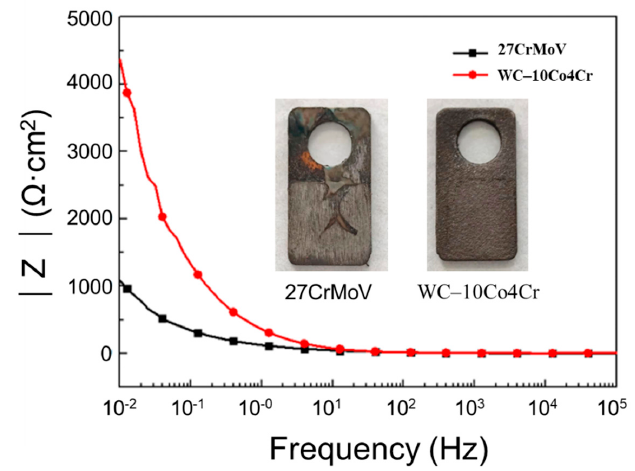
Figure 6. Bode diagram of EIS of 27CrMoV and WC–10Co4Cr coatings measured in saturated saline solution. The inset images show the macroscopic morphology of the sample after the corrosion test. The erosion behavior of the drill pipe under drilling fluid conditions was analyzed by simulation and experiment. Figure 7a,b shows the simulated results of the erosion rate distributions of 27CrMoV and WC–10Co4Cr coating for the drill pipe. It can be seen that the most serious erosion occurred in the pipe joint area, which is close to the inlet of the flow field and with large geometric deformation. This area is subject to maximum fluid scour from the drill fluid. Figure 7c gives the values of the erosion rate obtained by simu- lation (analog value) and experiment (test value). The test values of the erosion rate are 4.8 and 3.1 mg/(cm 2 ·d) for 27CrMoV and WC–10Co4Cr coating, respectively. The analog values of the erosion rate are 3.6 and 1.2 mg/(cm 2 ·d) for 27CrMoV and WC–10Co4Cr coat- ing, respectively. The difference between the test and analog values is due to the meas- urement error and the setting of boundary conditions. However, both the results show that the erosion resistance of the coating is better than that of the substrate. The erosion resistance of the coating increased to more than 30% higher than that of the 27CrMoV substrate. Figure 7. Erosion rate distributions of the ( a ) 27CrMoV substrate and ( b ) WC–10Co4Cr coatings for the drill pipe obtained by simulation. ( c ) Comparison of the erosion rates of 27CrMoV substrate and WC–10Co4Cr coatings obtained by simulation and experiment.